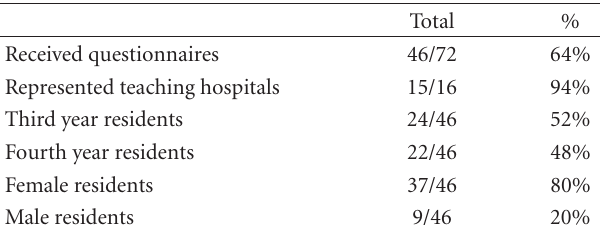
Table 1: Demographics of